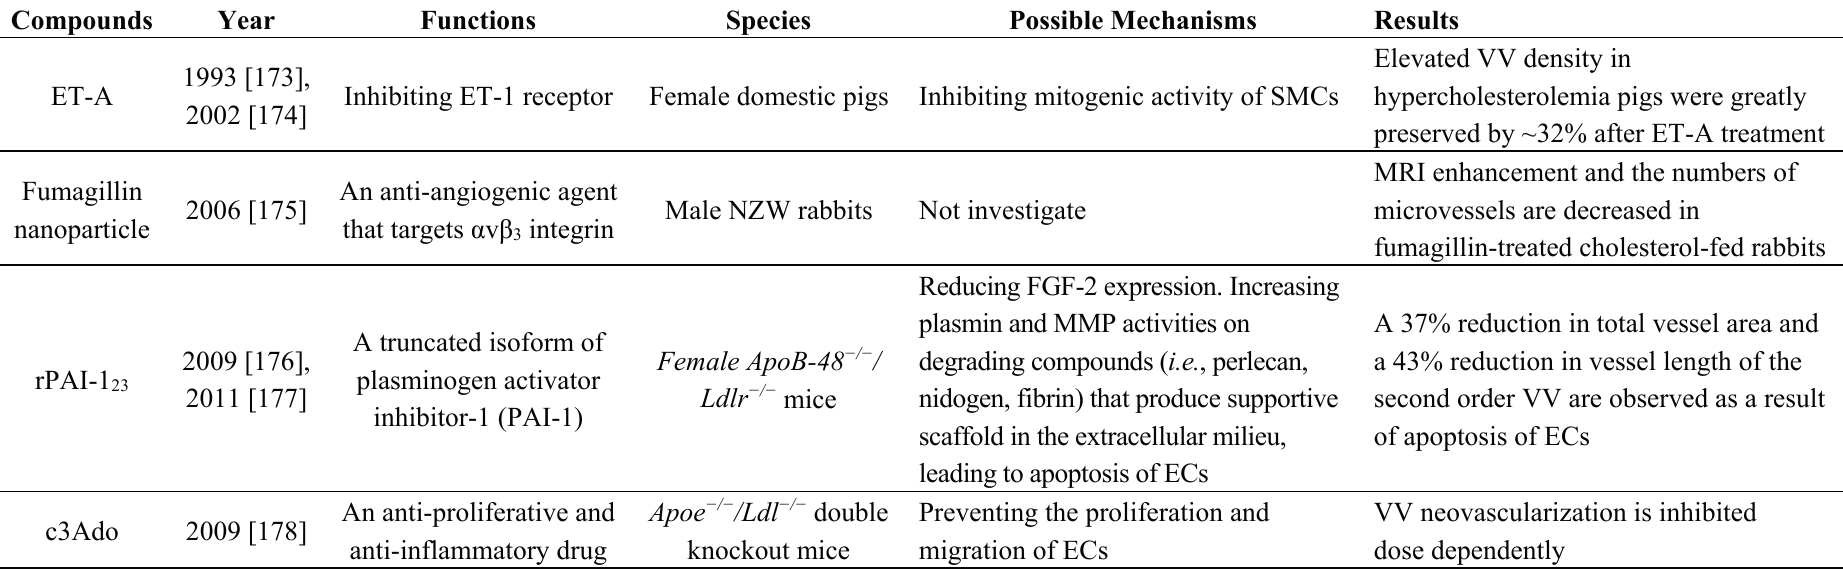
Table 2. Anti-angiogenic molecules with incompletely characterized